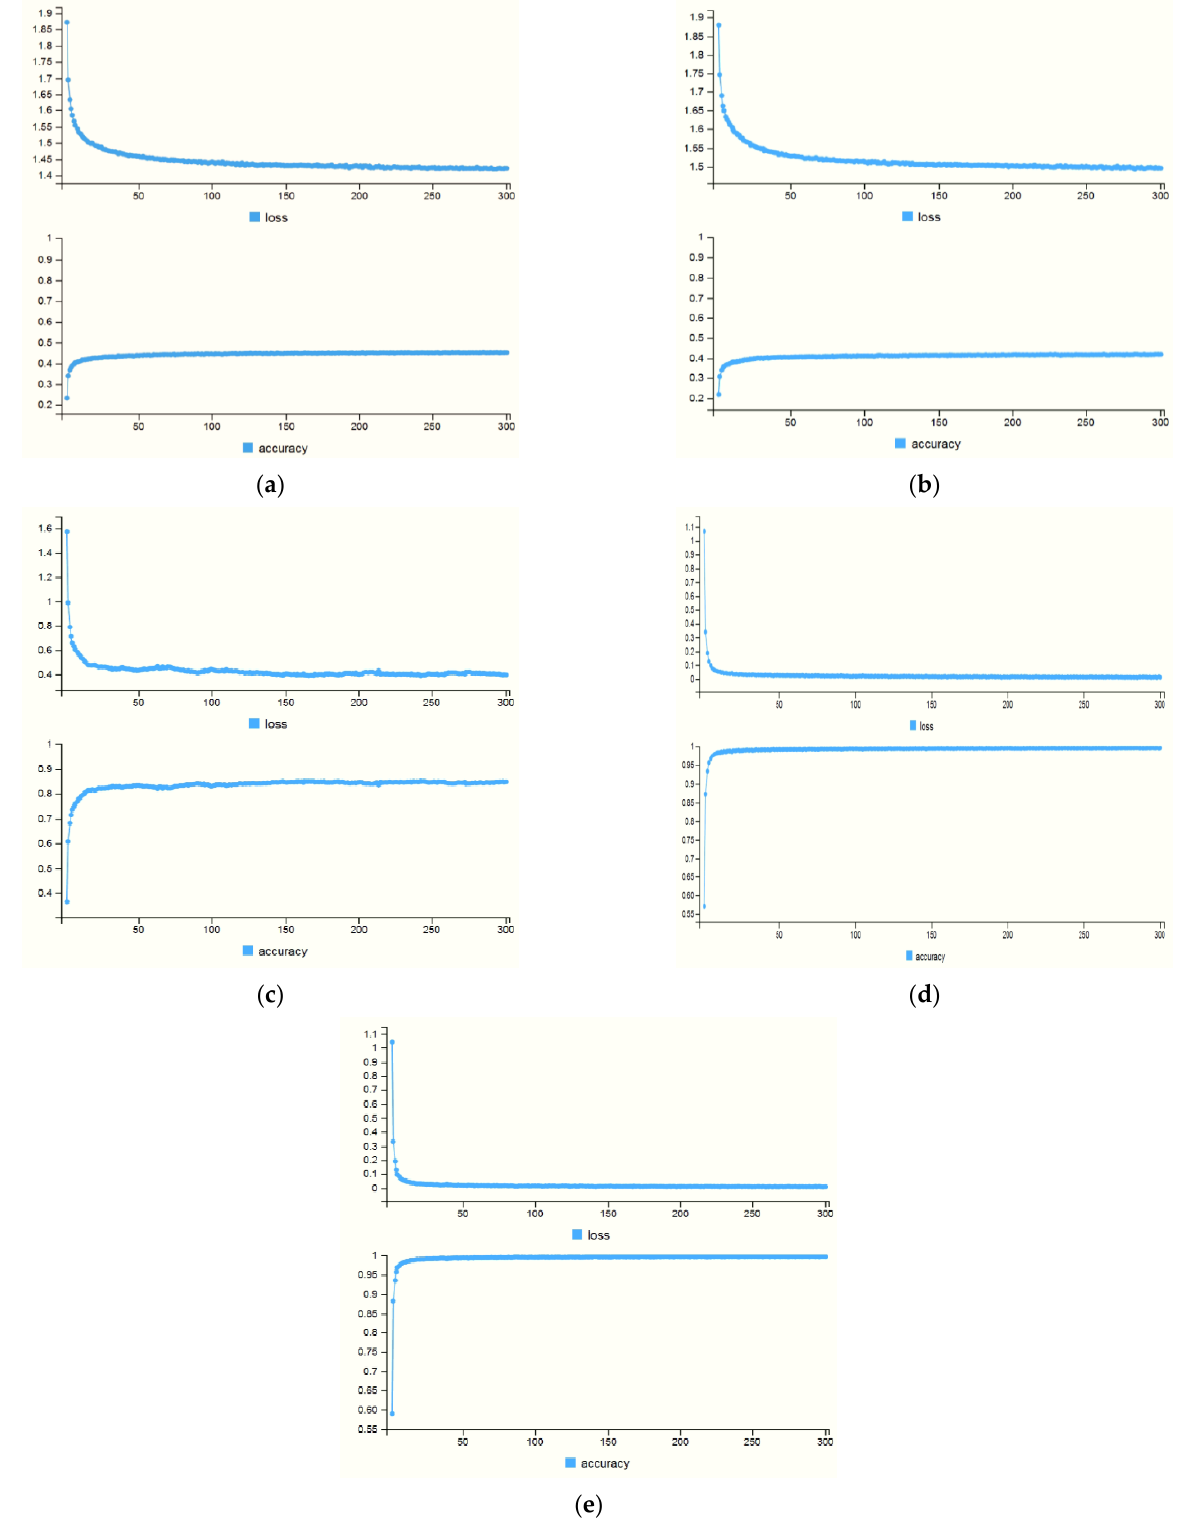
Figure 5. ( a ) Training model with Acc XYZ. ( b ) Training model with Gyro XYZ. ( c ) Training model with Rot XYZ. ( d ) Training model with Rot vector — 9, ( e ) Training model with all data sets . Table 3 shows the result of this evaluation. Model training with acceleration (Acc X, Y, Z) in X, Y, and Z direct ions data sets indicates a 50.5% accuracy in classifying subjects’